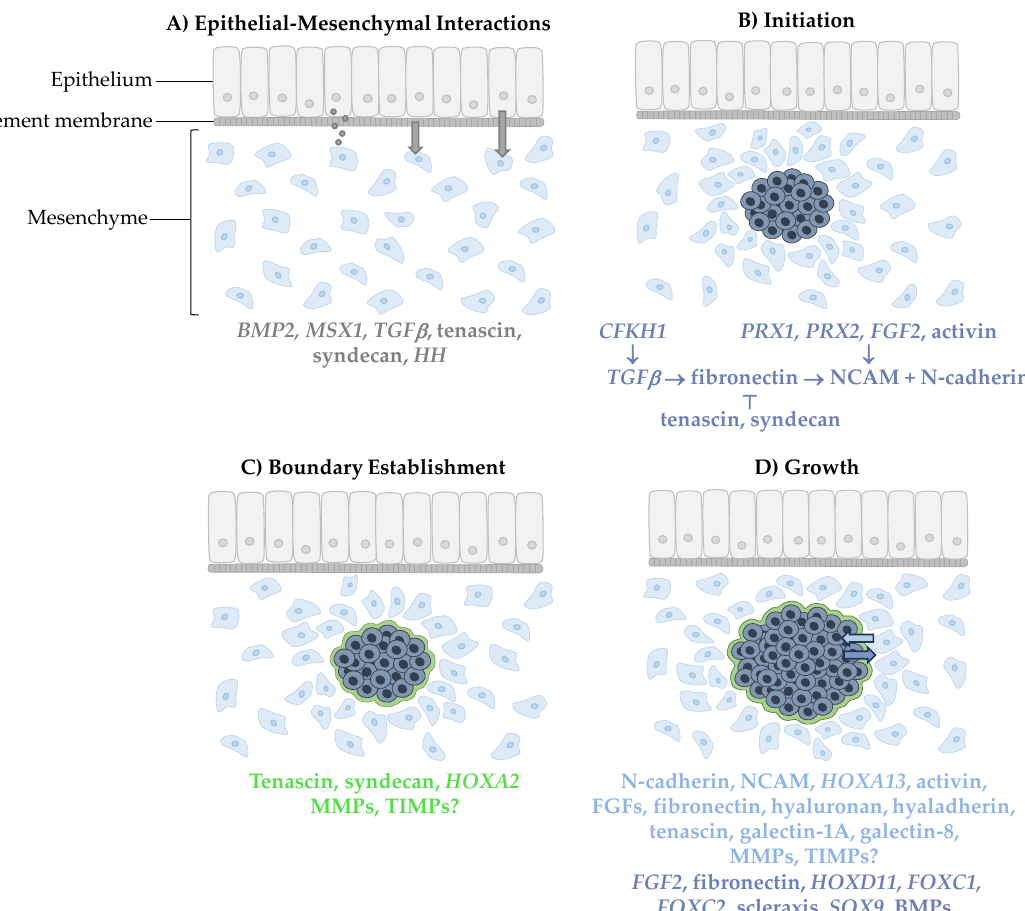
Figure 1. Condensation formation. ( A ) Mesenchymal cells are first induced by epithelial signaling molecules through diffusion, close interaction with the basement membrane or direct cell–cell interaction. ( B ) Condensation is then initiated by a signaling pathway involving neural cell adhesion molecules (NCAM) and N-cadherin. ( C ) A boundary surrounding the condensed cells is then established which permits ( D ) growth of the condensation from incoming cells that adhere to the condensation and cells undergoing proliferation within the condensation. Signaling molecules involved in each step are color-coded for the location in which they appear. Grey, dark blue, green, and light blue correspond to epithelial cells, condensed cells, the condensation boundary, and mesenchymal cells, respectively.